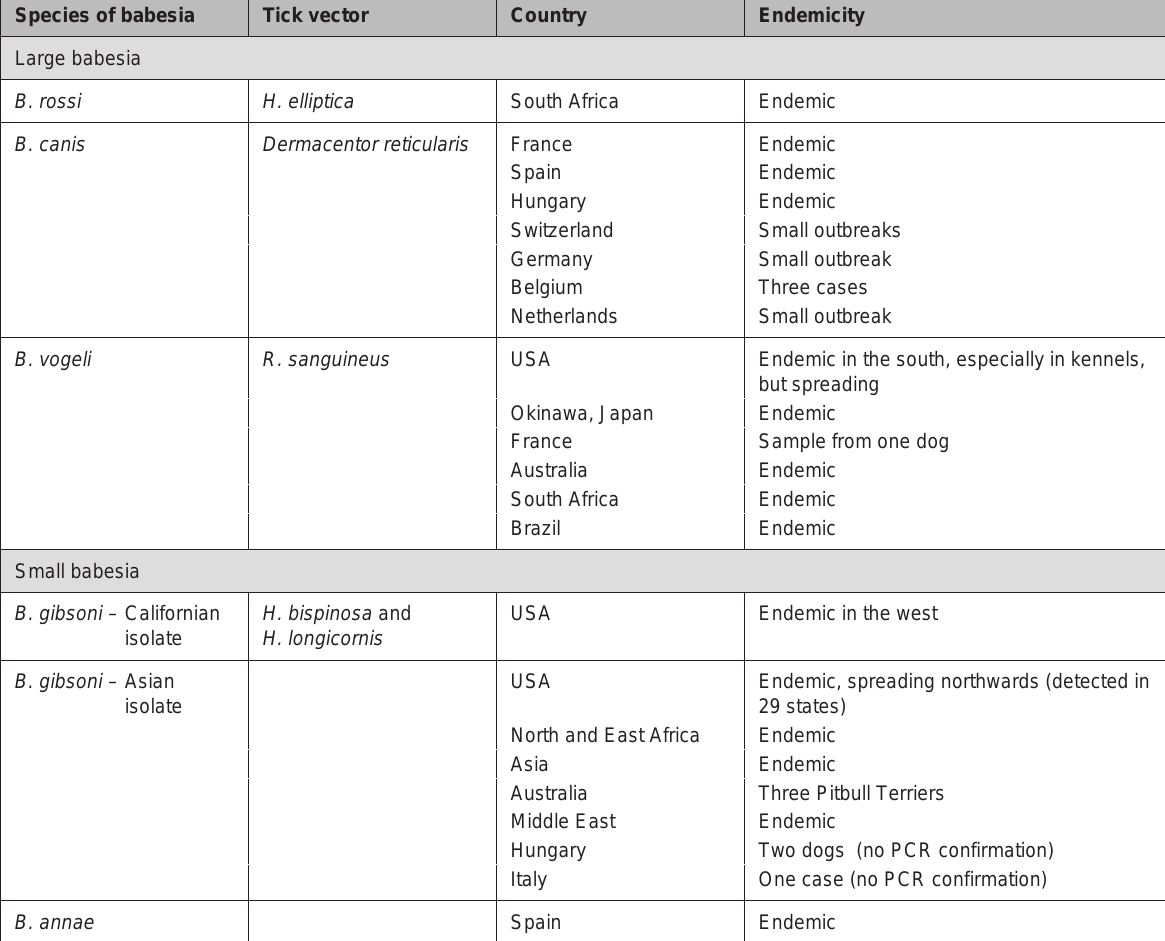
TABLE 1 Geographical spread of canine babesiosis Species of babesia Tick vector Large